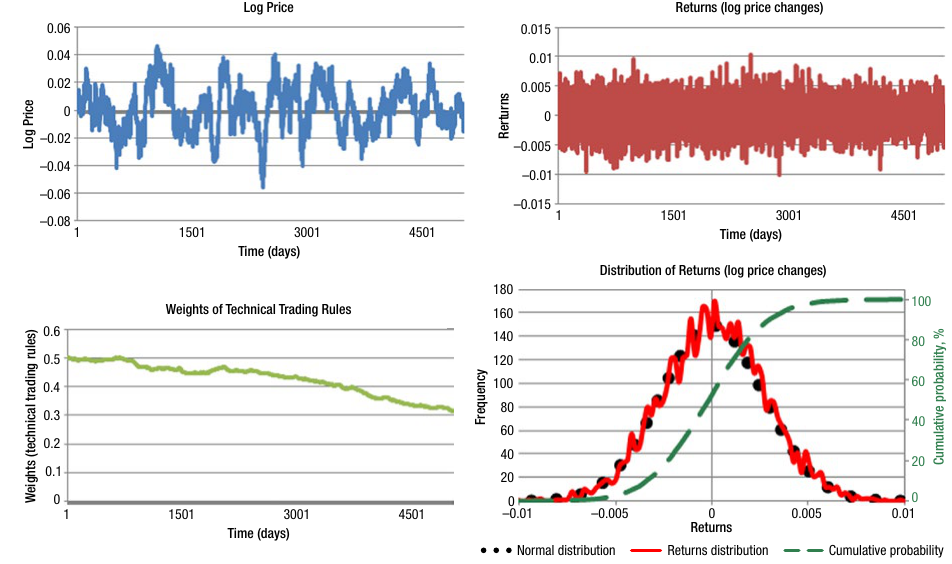
Fig. 2. Simulation results in original model ( source : authors)